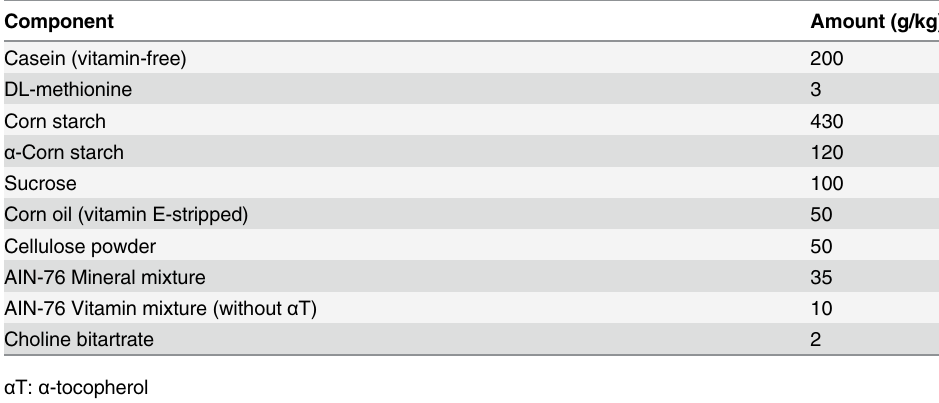
Table 1. Composition of a α T-deficient